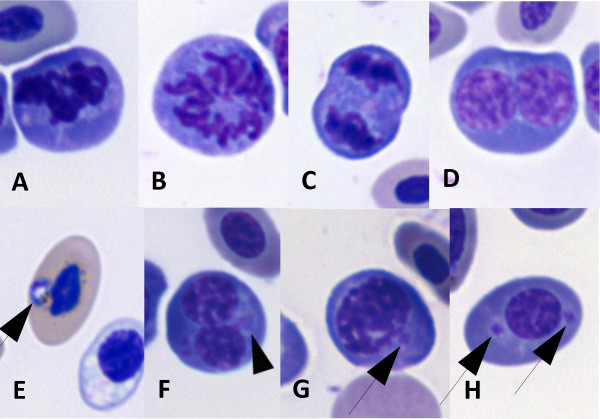
Blood of chickens infected with Plasmodium gallinaceum presented immature erythrocytes that were also infected. Erythrocyte at prophase (A), prometaphase (B), anaphase (C) and telophase (D) were seen. Mature (E) and immature erythrocytes (F, G, H) were infected (arrowheads).